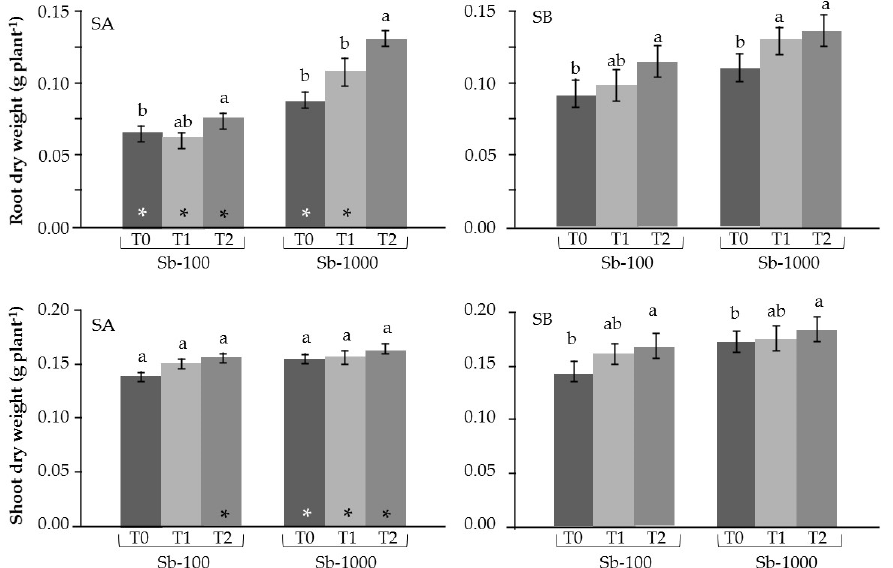
Figure 7. Root and shoot dry weight of triticale plants grown in amended and unamended Sb-polluted SA and SB soils. Average values (histograms) and standard errors (bars) are reported. T0, T1 and T2 refer to MSWC addition, i.e., 0, 1 and 2%, respectively. For each soil (SA and SB) and Sb concentration level, different letters denote significant differences between treatments (Tukey–Kramer test; p < 0.05). For each plant part, asterisks denote significant differences between SA-100 and SB-100, and between SA-1000 and SB-1000 (Student t-test; p < 0.05).